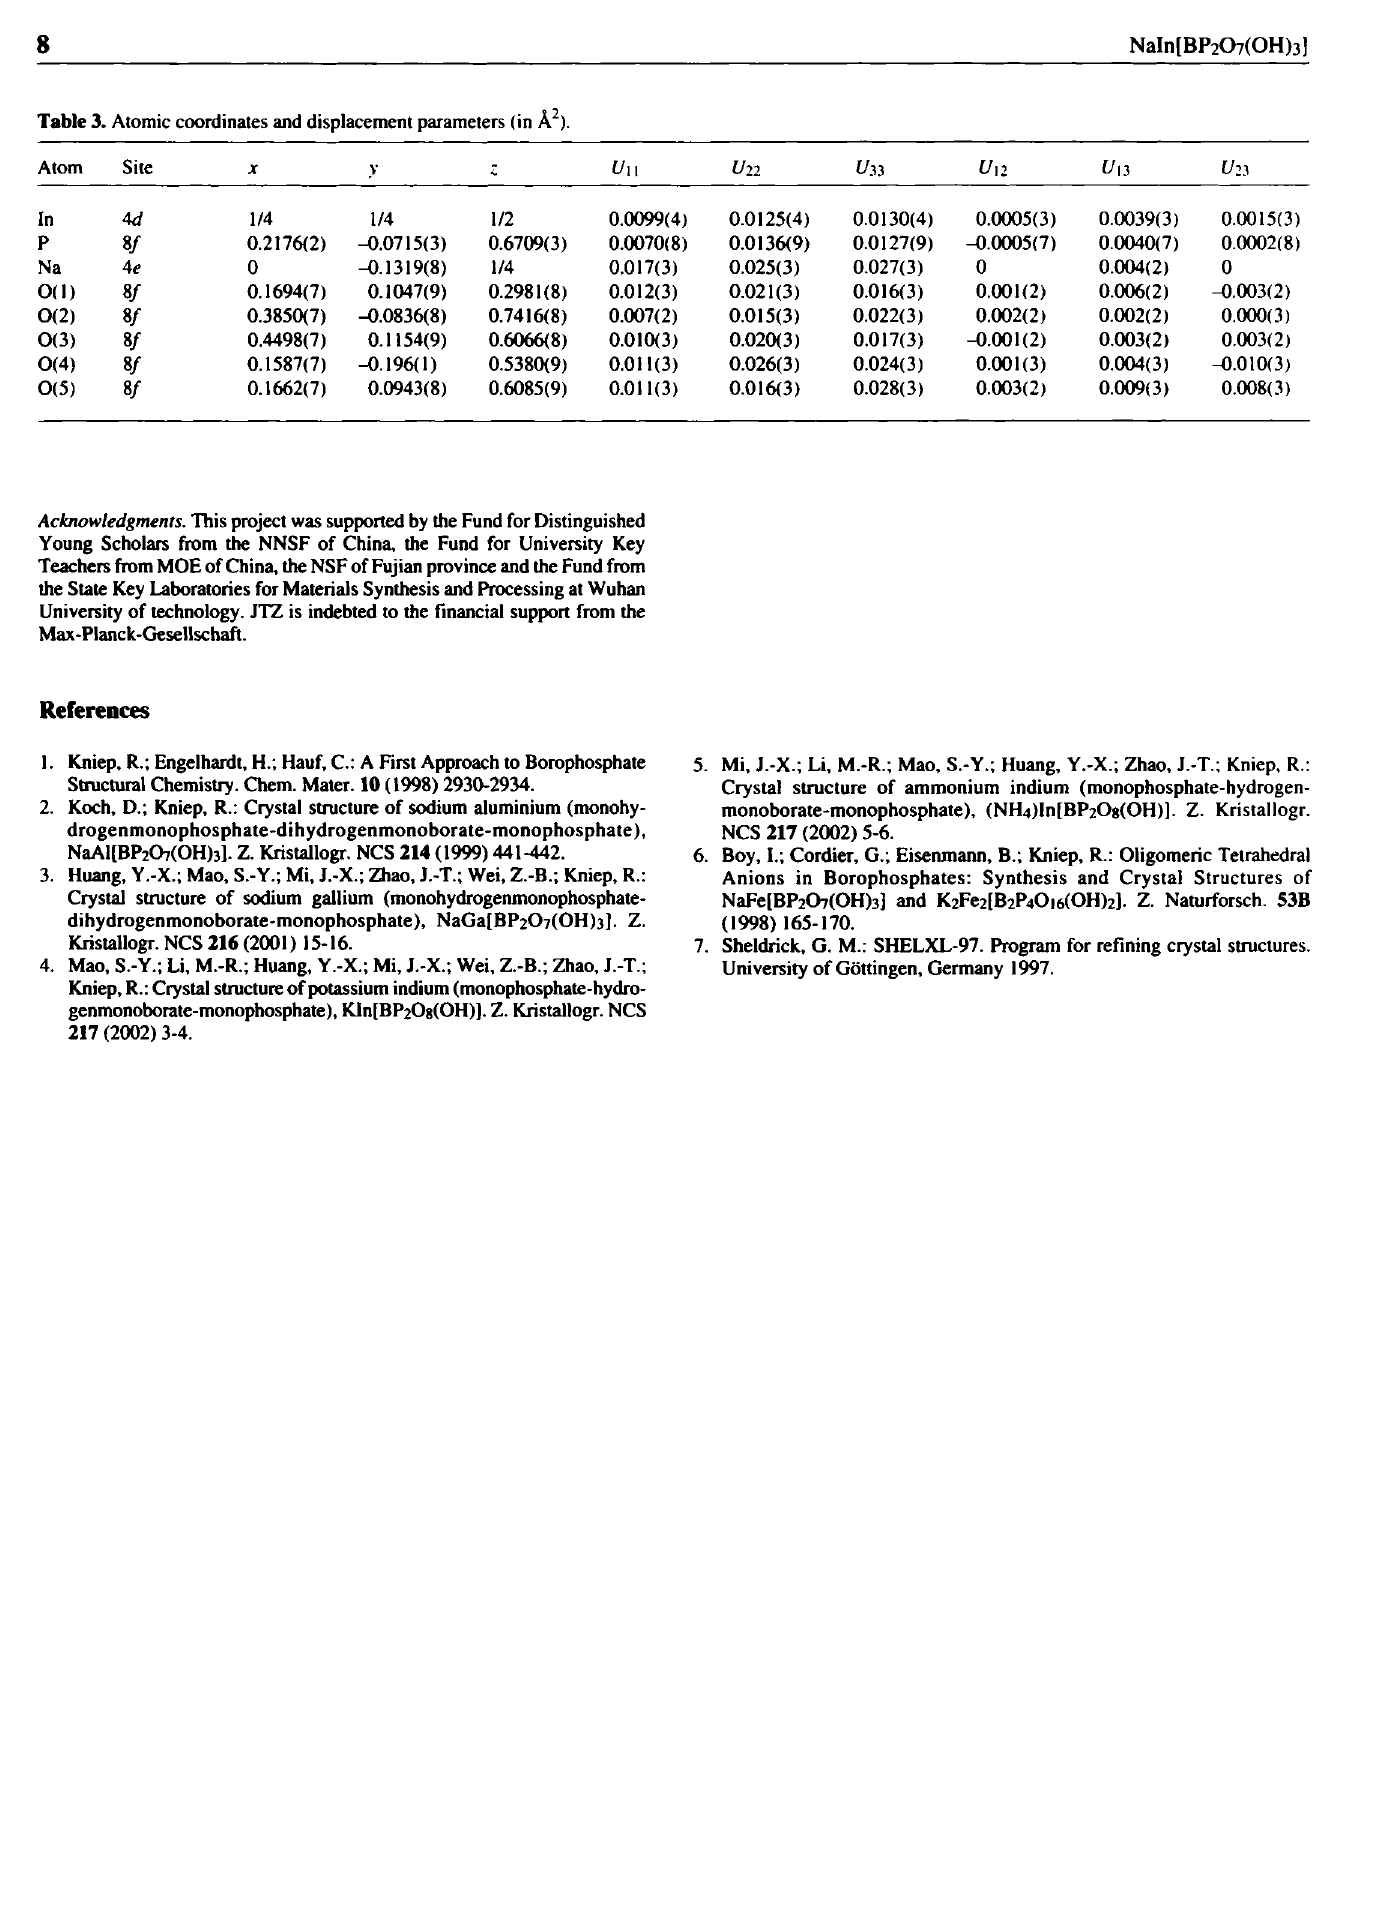
Table 3. Atomic coordinates and displacement parameters (in Â 2